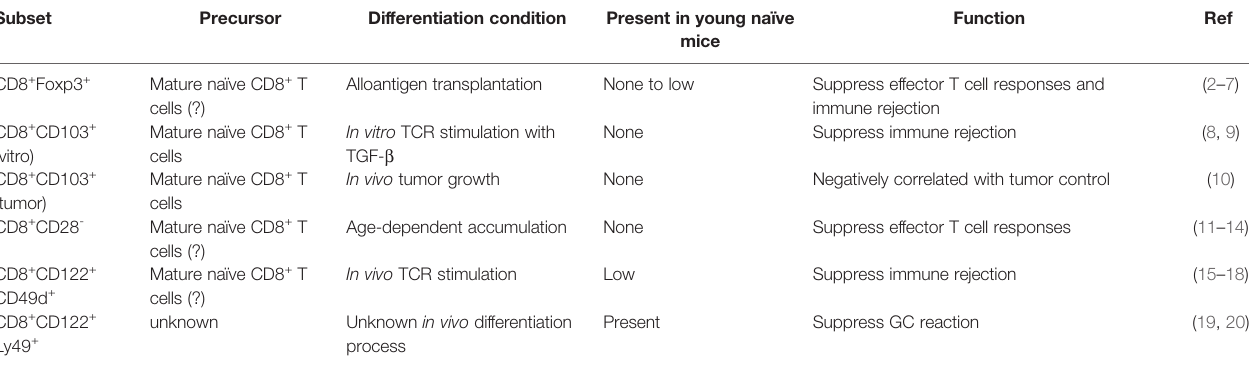
TABLE 1 | Major “ CD8 + Treg ”